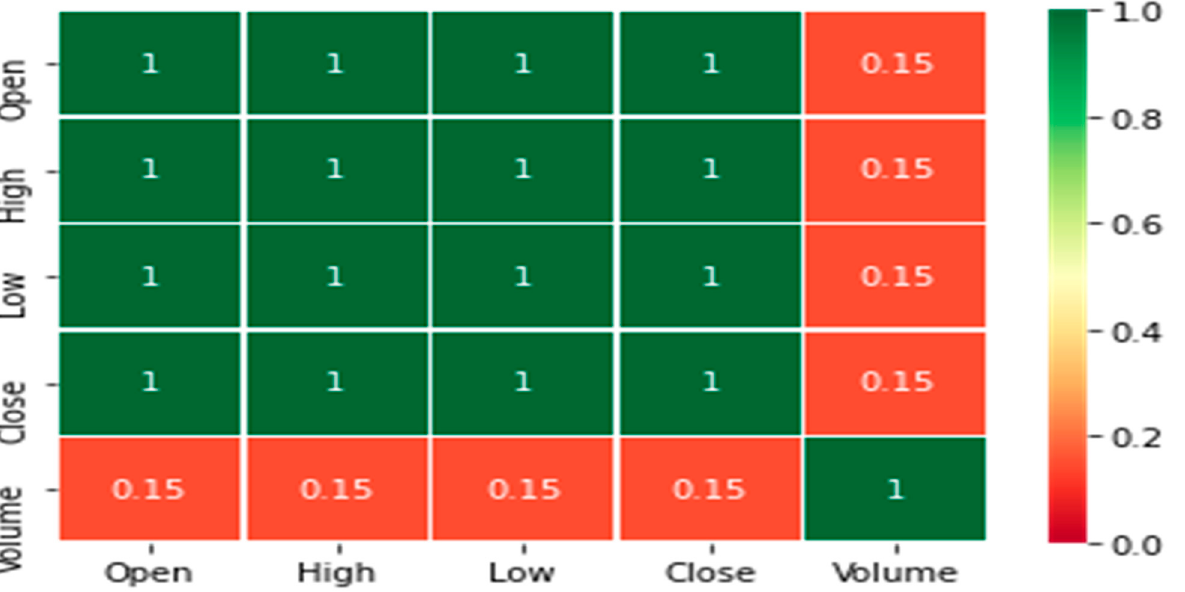
Figure 7. Forecasting future values in time-period of 60 days. ( a ) GRU model and ( b ) MLP model. There are five important characteristics contained inside the bitcoin data. The corre- lation strategy was put into action so that correlations could be discovered between these traits. The relationships between the attributes of bitcoin cryptocurrency are illustrated in Figure 8.